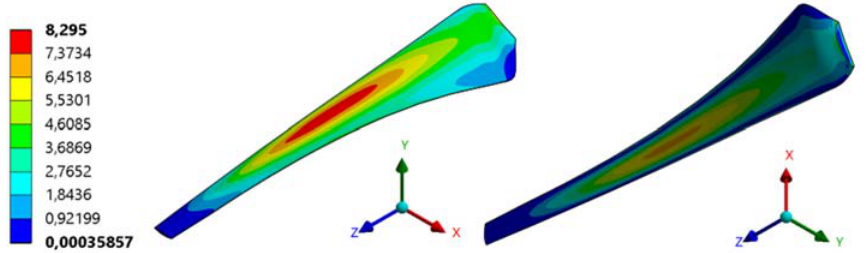
Figure 12. Map of equivalent (von Mises) stresses appearing in the blade σ max (in MPa).